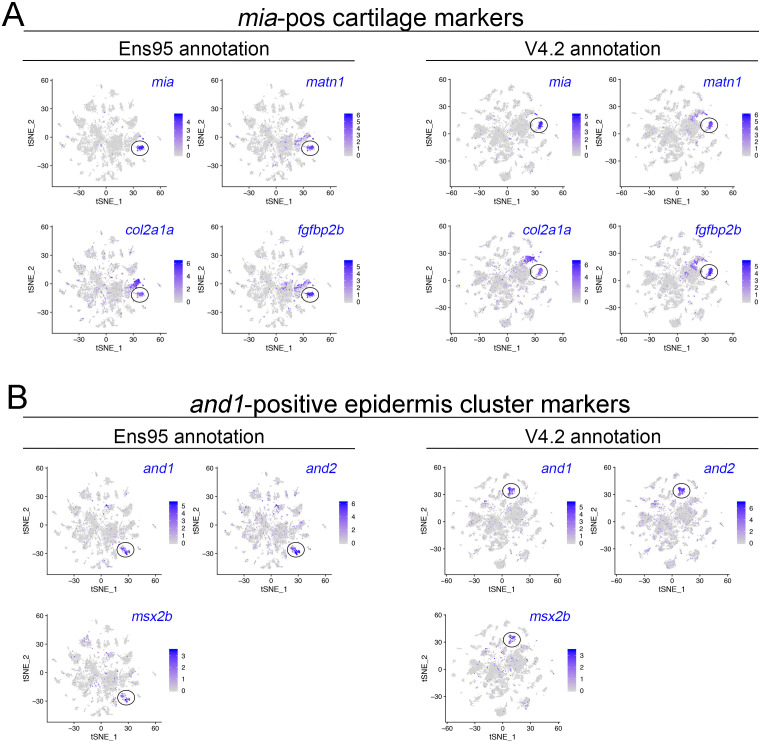
Identification of cartilage and epidermis cell clusters in scRNA-seq data.(A) tSNE plots showing expression of cartilage markers mia, matn1, col2a1a, and fgfbp2 using clustering based on data quantified with Ens95 or V4.2, as indicated. (B) tSNE plots showing expression of epidermis markers and1, and2, and msx2b using clustering based on data quantified with Ens95 or V4.2, as indicated. (A, B) Legends indicate log-transformed normalized expression level per cell.